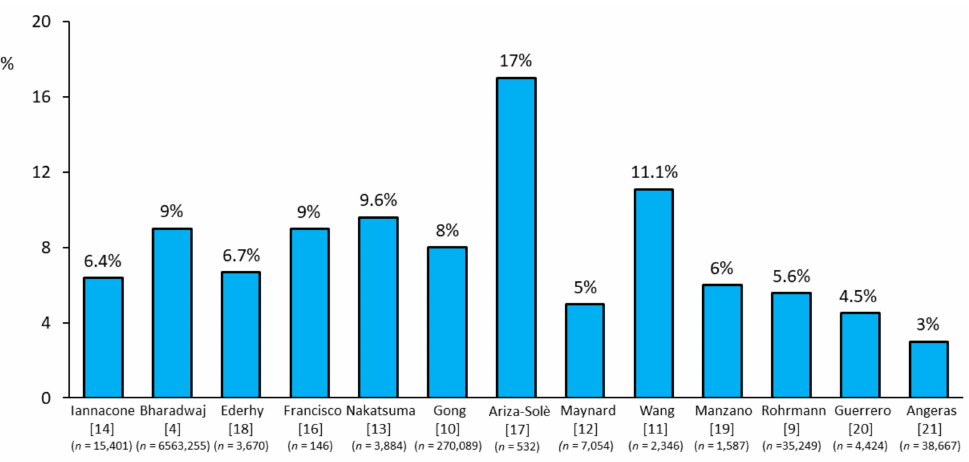
Figure 1. Prevalence of acute coronary syndrome events reported in cancer patients across studies